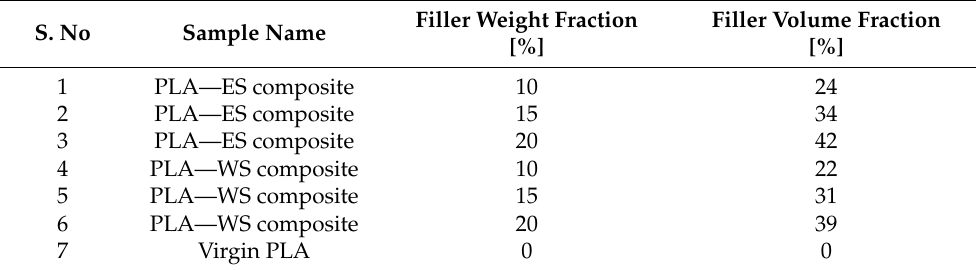
Table 1. Filler weight and volume fractions of virgin PLA and filler-based PLA composites based on theoretical calculations.